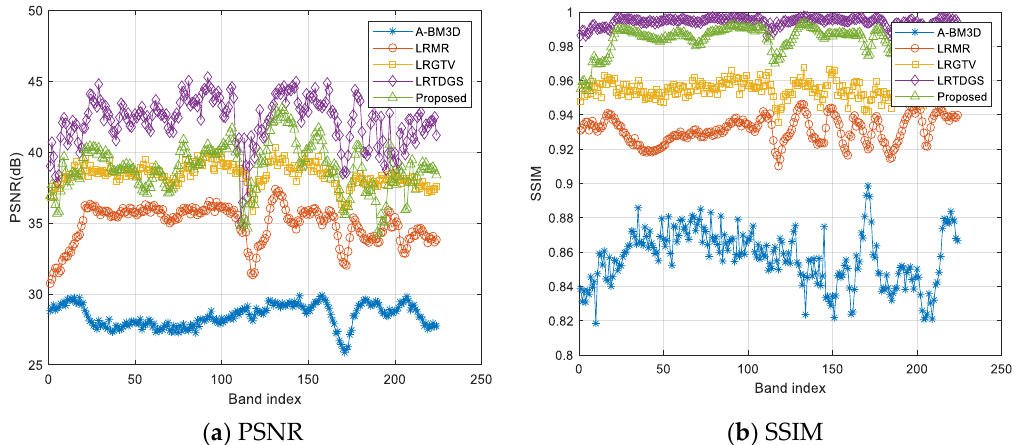
Figure 5. PSNR and SSIM values of restored results by different methods on Simu – Indian data (G = 0.10, S = 0.10).